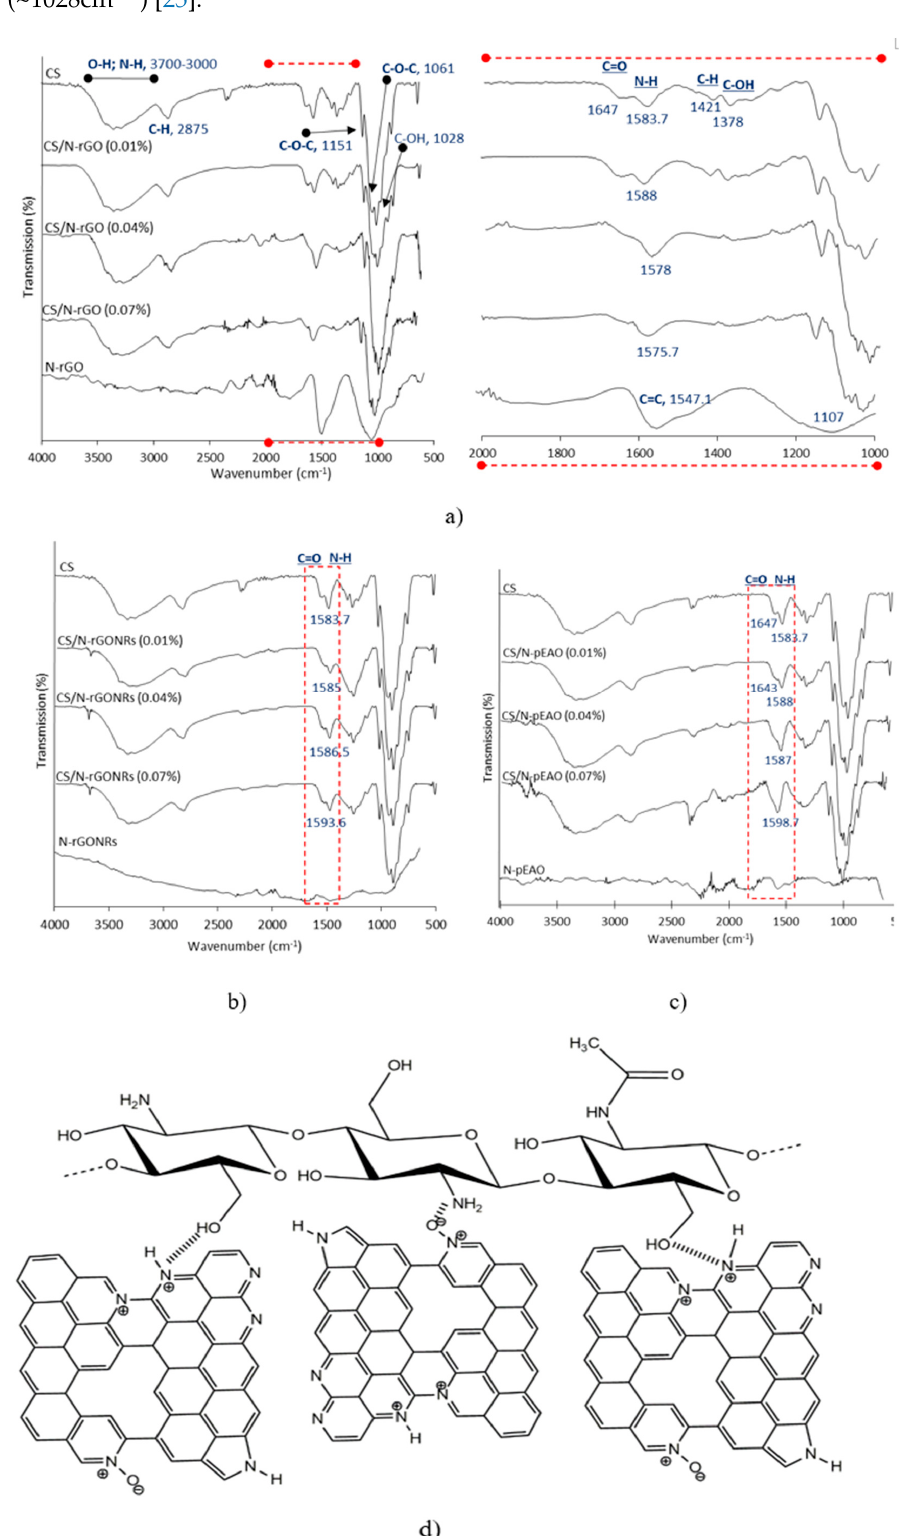
Figure 7. FTIR spectrum of neat CS and CS/graphene composite membranes, containing 0.01%, 0.04% and 0.07% of ( a ) N ‐ rGO, ( b ) N ‐ rGONRs and ( c ) N ‐ pEAO. The spectra are offset vertically to aid visibility. ( d ) Tentative scheme of CS ‐ graphene interaction within composite membranes.